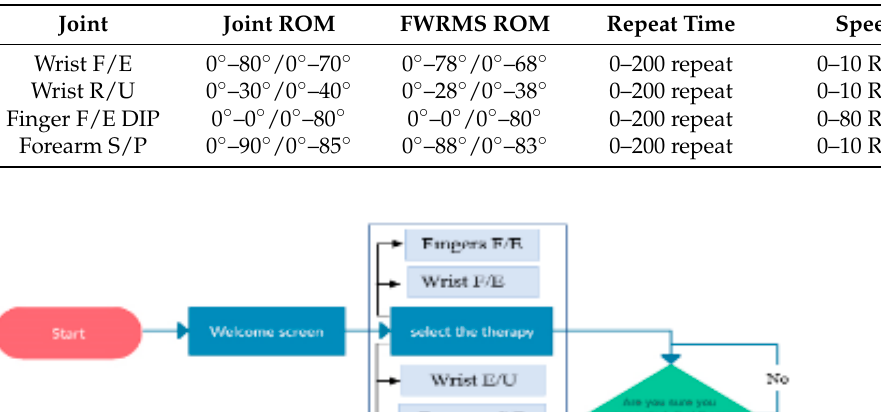
Table 2. Technical specifications of FWRMS device.